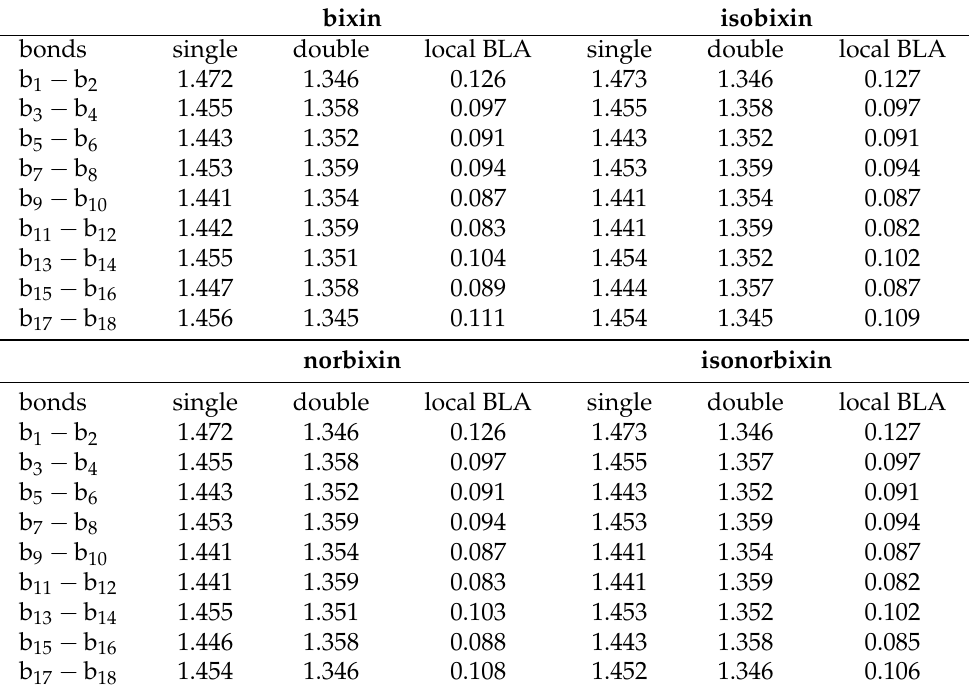
Table A5. Single-double bonds and local BLA values (Å) of the molecular dyes in chloroform solution. These results were obtained by employing the CAM-B3LYP/6-31+G(d,p) level of